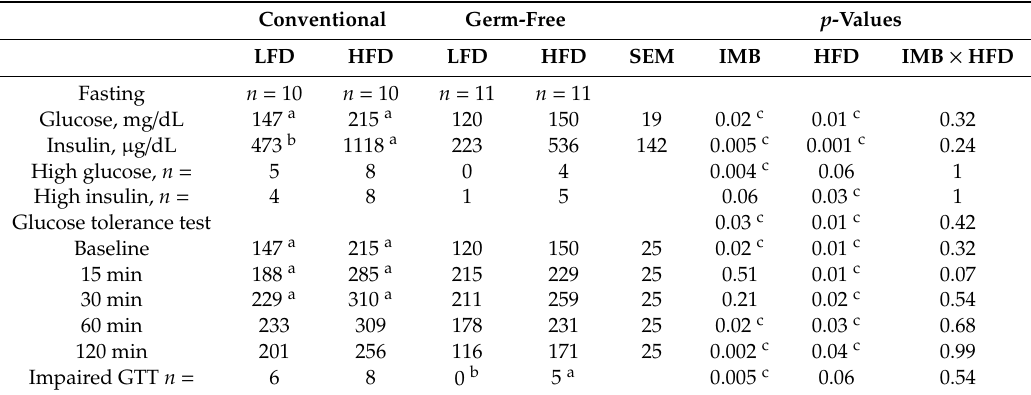
Table 4. E ff ect of the low- and high-fat diets on glucose metabolism in conventional and germ-free male Tac:SW mice. Conventional Germ-Free p -Values